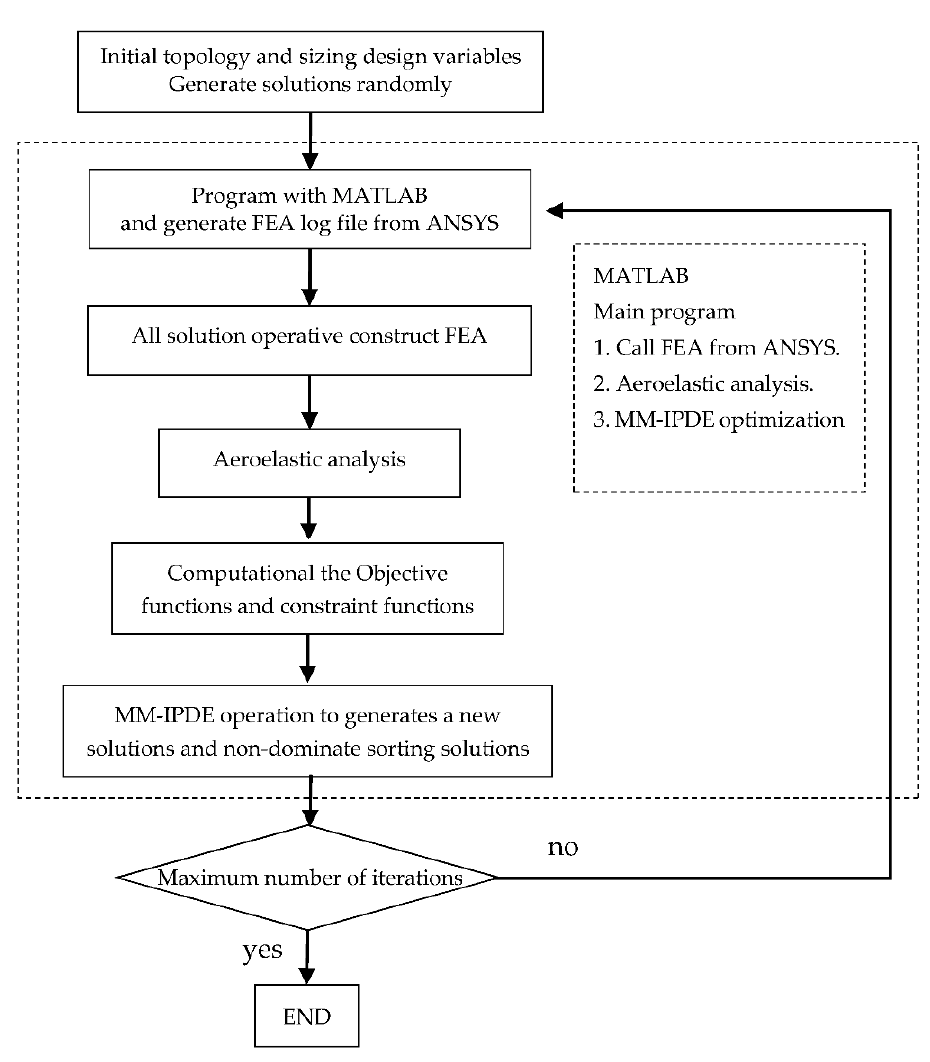
Figure 7. The process of a MOTO simulation model.